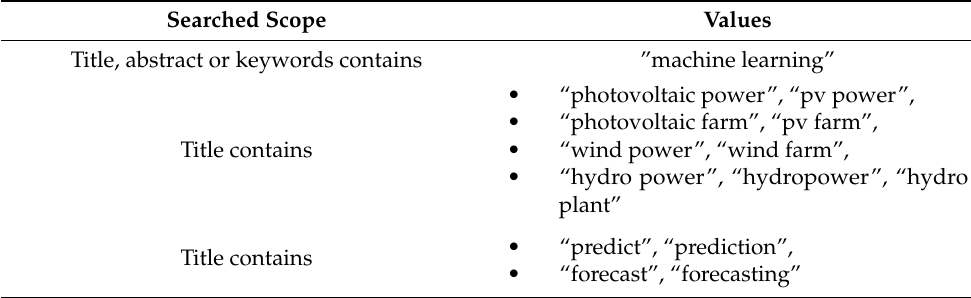
Table 1. List of search keywords and search scopes.